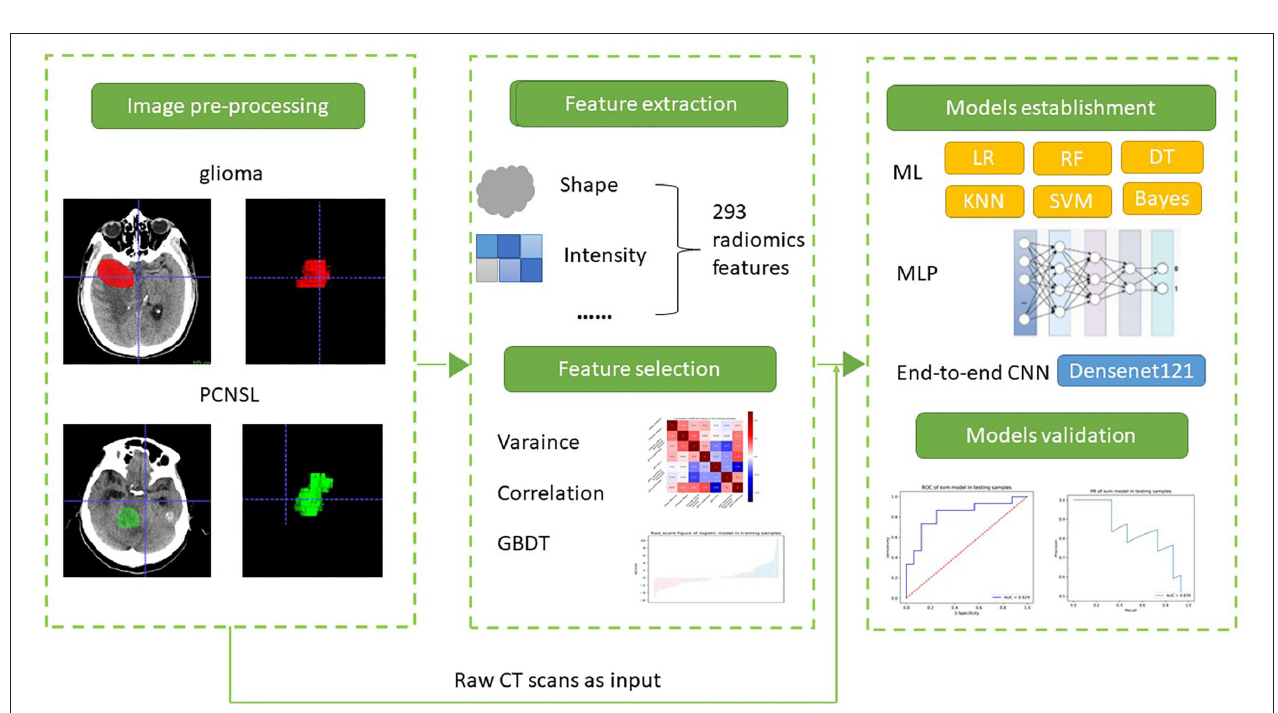
Frontiers in Neurology |